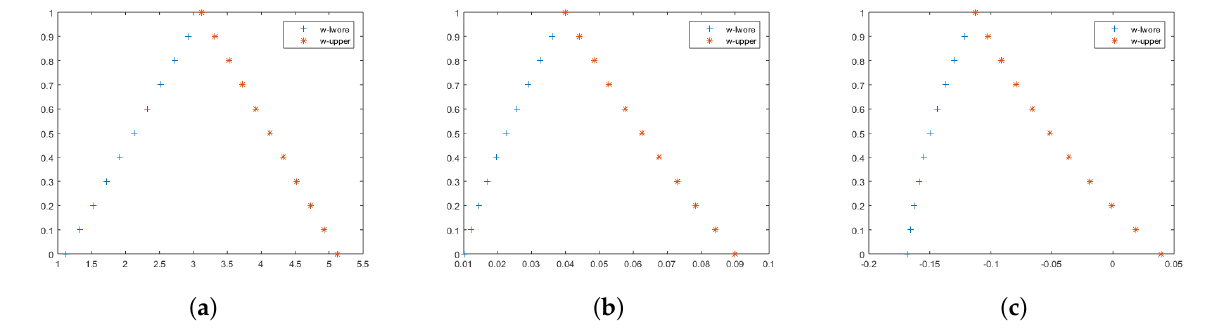
Figure 1. The exact lower and upper solutions of Equation (16) at ( a ) Λ = 0.2, t = 0.3, ı = 1, for Equation (32) at ( b ) Λ = 0.00001, t = 0.5, ı = 2, and for Equation (50) at ( c ) Λ = 0.3, t = 0.7, ı =